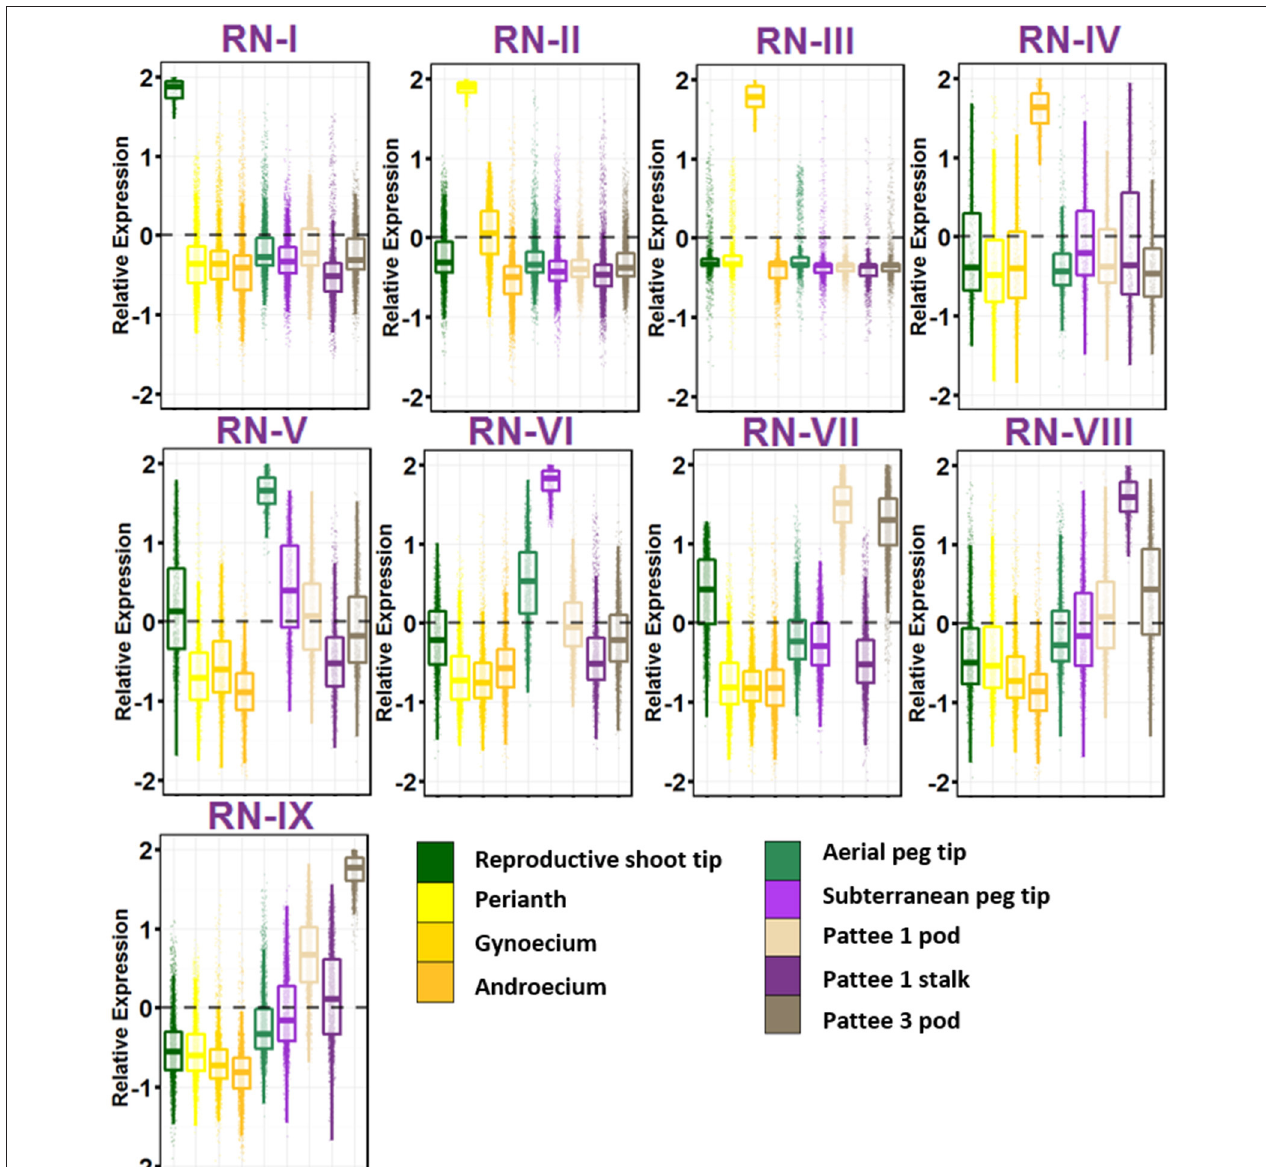
FIGURE 3 | Reproductive Gene Networks (RN). Relative expression is Z-score transformed FPKM. Pattee refers to the stages of peanut development established in Pattee et al. (1974). Plots are jigger boxplots with every gene’s normalized gene expression shown in the plot. Boxplot is traditional boxplot with median, and upper and lower quartiles. Each tissue is colored as in key to right in the same